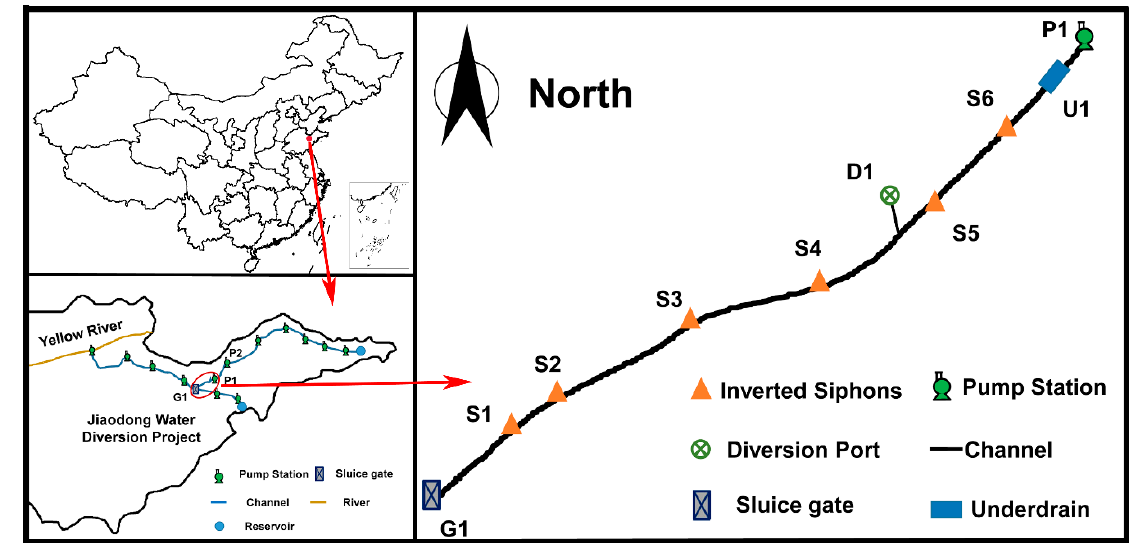
Figure 4. The layout of the engineering project.